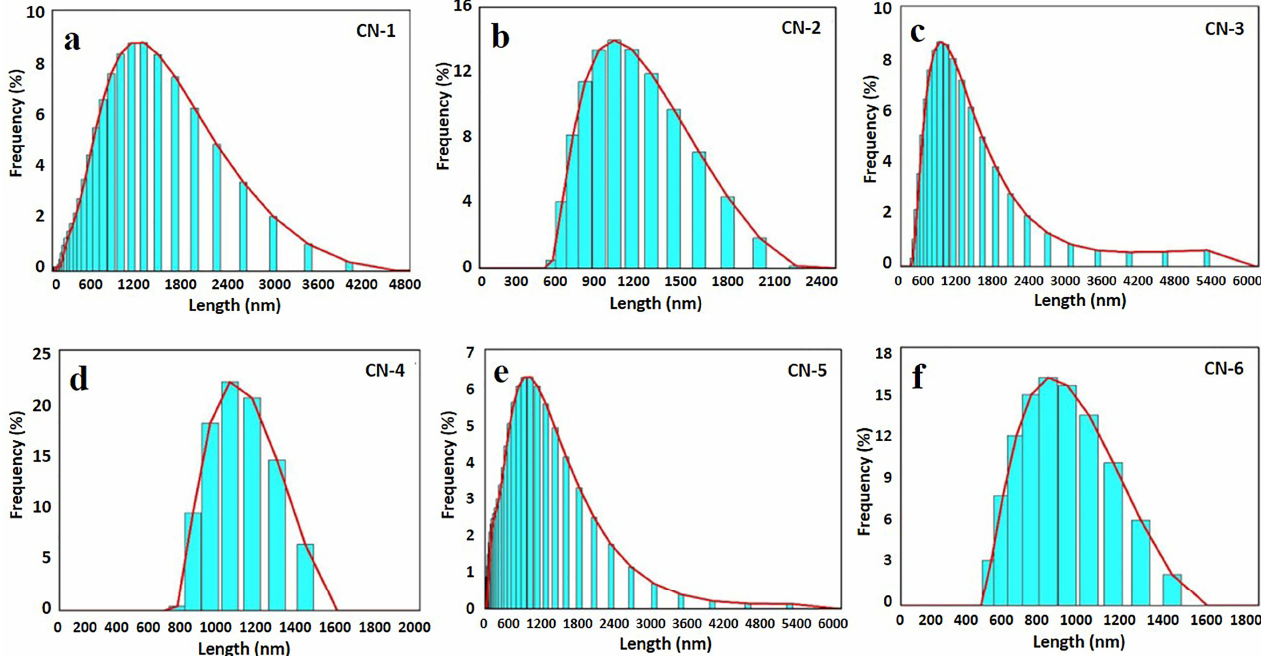
Figure 1. Particle size distribution (by DLS method) of prepared CNC suspensions of ( a ) CN-1, ( b ) CN-2, ( c ) CN-3, ( d ) CN-4, ( e ) CN-5, and ( f )